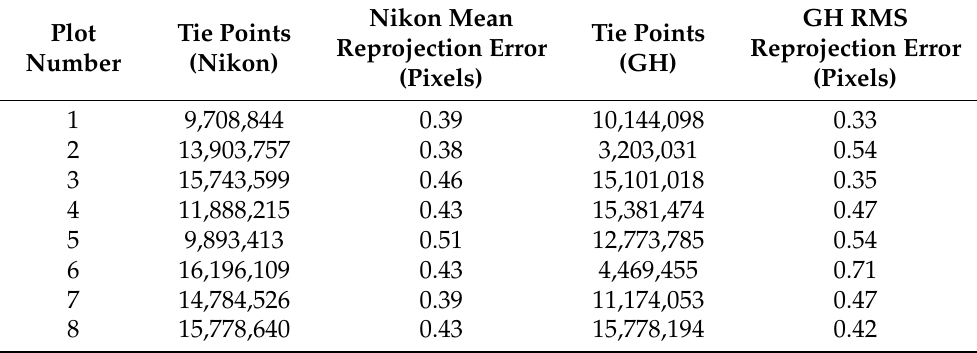
Table 9. Photogrammetric reconstruction results for Nikon and GH measurements for each plot.